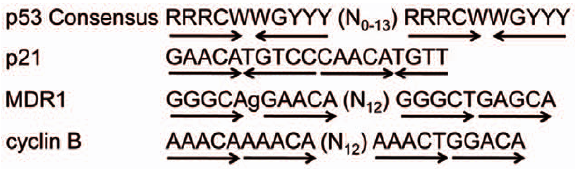
Figure 1. Comparison of head-to-head and head-to-tail p53 response elements. The consensus sequence of the standard p53 response element consists of two half-sites, each with quarter-sites oriented in a head-to-head manner (indicated by arrows). R= purine, Y= pyrimidine, W=A/T, and N=A/T/C/G. The p21 promoter contains a standard head-to-head p53 response element, while the MDR1 and cyclin B genes contain p53 response elements with head-to-tail